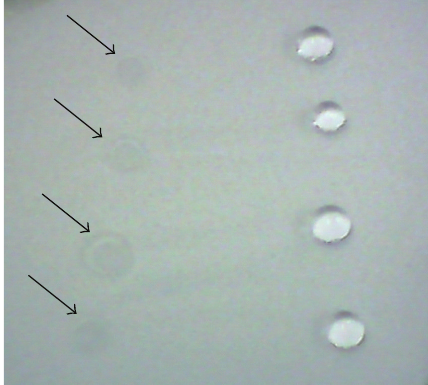
Figure 1: Wettability difference between ethanol and water in UHMWPE